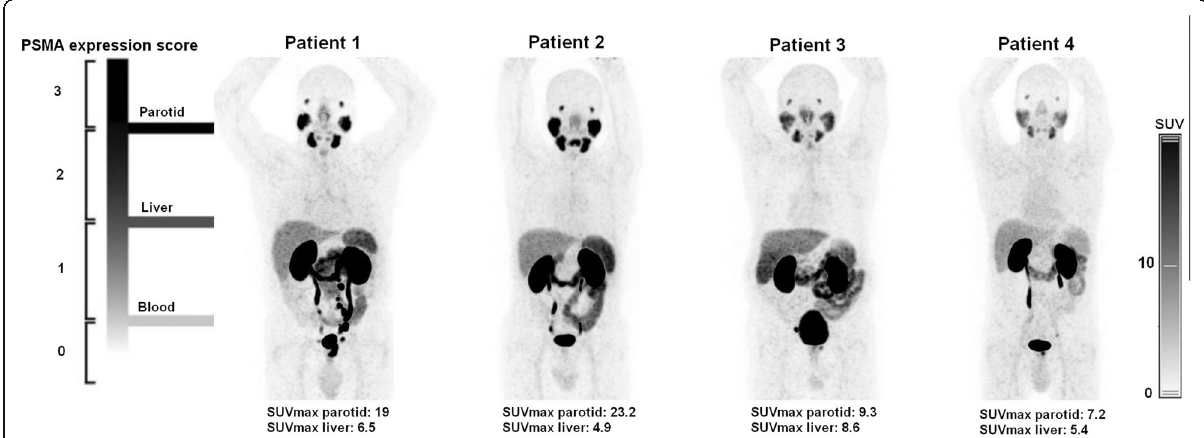
Fig. 4 [ 68 Ga]Ga-PSMA-11 PET maximum intensity projection images of four patients showing interindividual variability of PSMA expression of the liver and parotid, reference organs. The visual distinction between parotids and liver miPSMA expression scores is simple for patients 1 and 2 while miPSMA expression scores of liver and parotids is visually similar for patients 3 and 4. Left side of the figure adapted from Eiber et al. figure